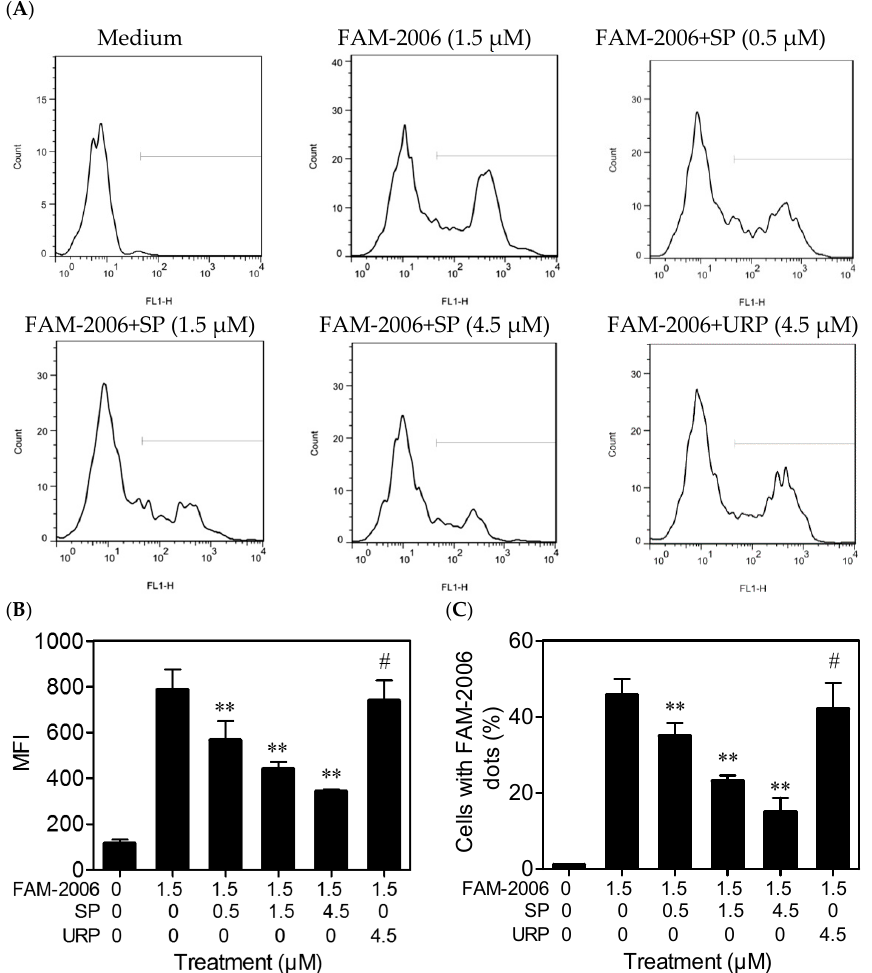
Figure 6. Synthetic peptide (SP) inhibited ODN2006 internalization, as assessed using flow cytometry analysis. RAW264.7 cells (5.0 × 10 5 cells) grown in 12-well plates were treated as described in Figure 5. After 30 min, cells were washed with cold phosphate buffered saline (PBS), detached with trypsin/ethylenediaminetetraacetic acid (EDTA), counted, and immediately detected by flow cytometry ( A ). Mean fluorescence intensity (MFI) values ( B ) and the percentages of cells with FAM-2006 dots (green fluorescence) ( C ) were calculated using the Flowjo software ( n = 3). “Count”, counted cells. “FL1-H”, the height of FL1 channel detecting FAM. “ ** ”, p < 0.01; “#”, p > 0.05 vs. FAM-2006 alone.